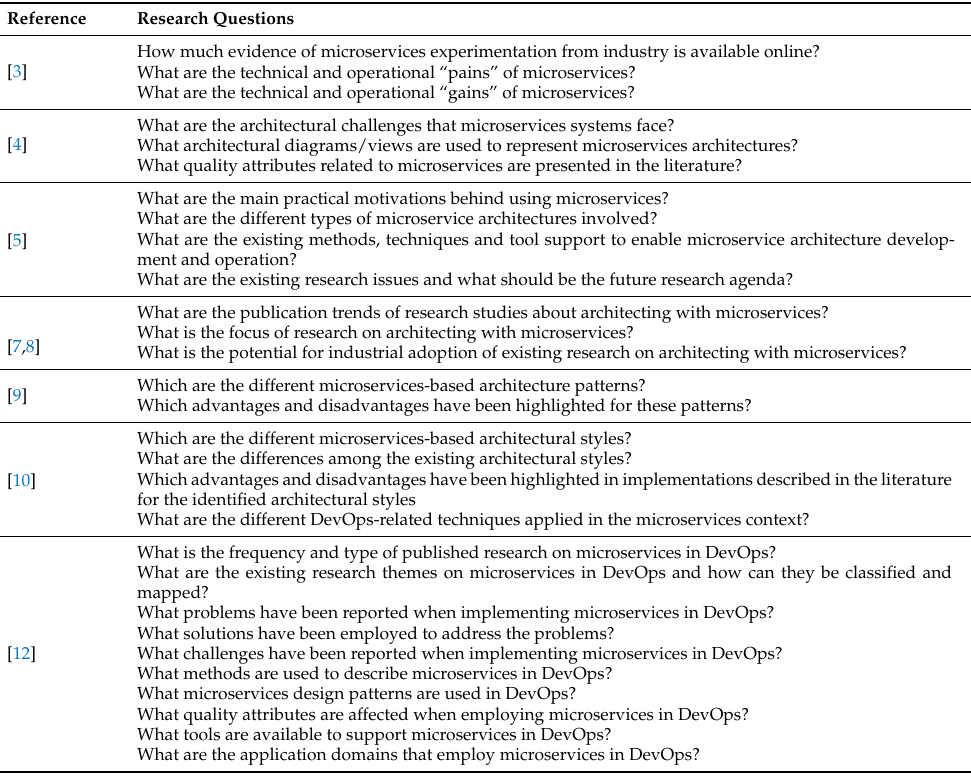
Table 1. Related Work Research